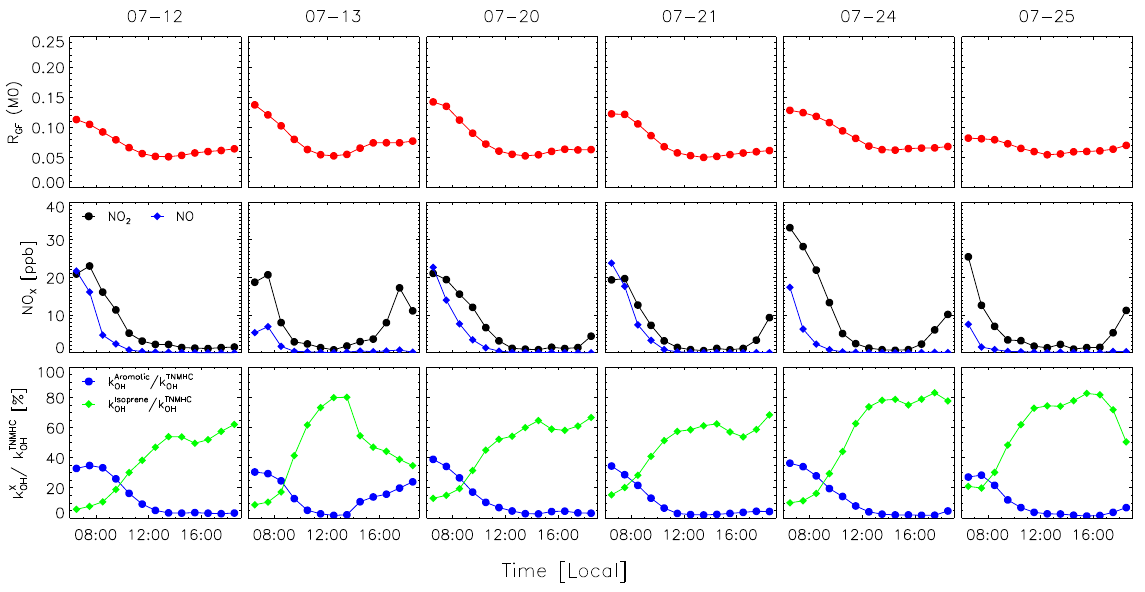
Fig. 4. Sensitivity analysis of HCHO and CHOCHO simulation for the 6 cloud-free days during the PRIDE- PRD2006 campaign. Dates color coded in red are the days which were influenced by local combustion events. The blue dots are the measured concentrations with error bars indicating the 1 σ statistic error of the measure- ments. Symbols with color black, orange, green, gray, and red represent the modeled concentrations by model base-case (M0), and M1 – M4, respectively. Detailed model settings are described in Table 1 in the text.